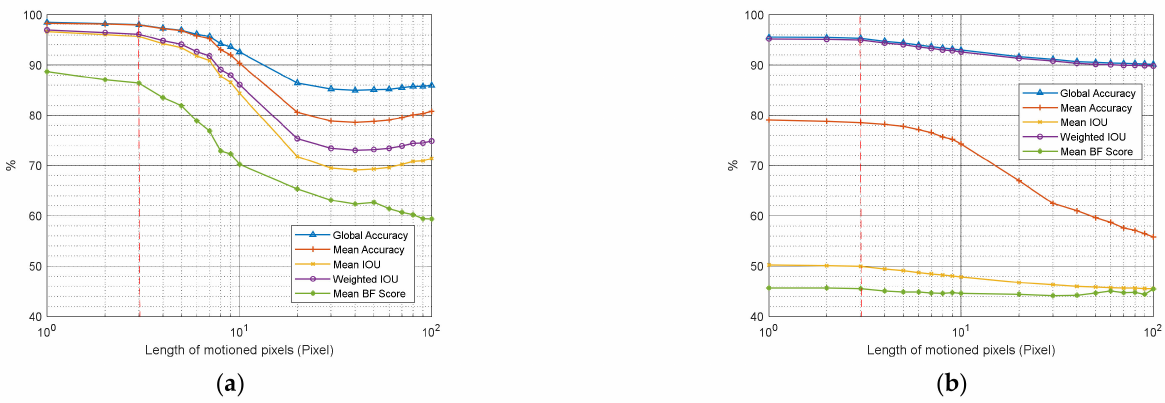
Figure 17. The effect of the UAV’s speed (logarithmic axis) on image acquisition and the accuracy of computer vision-based bridge component ( a ) and joint ( b )